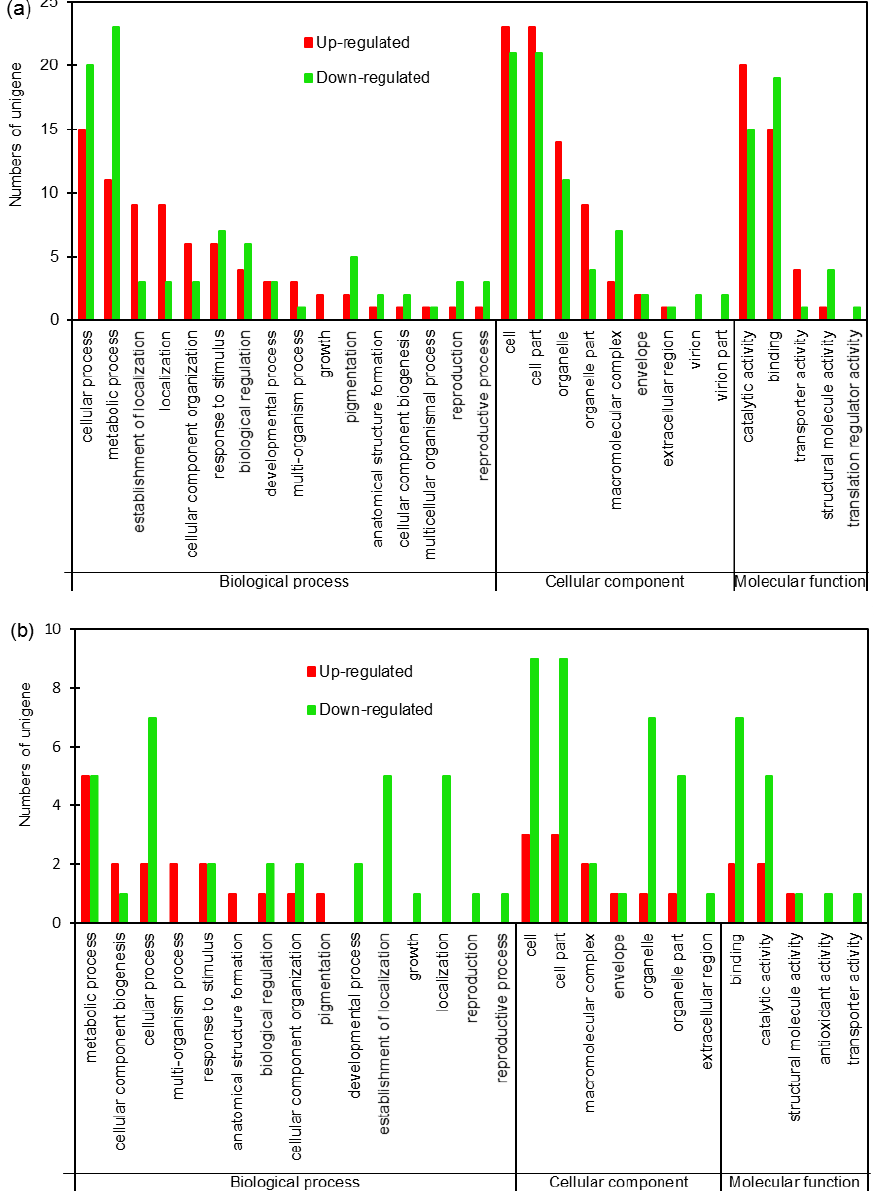
Figure 2. Gene Ontology (GO) analysis of the DEPs in roots ( a ) and shoots ( b ) of sugar beet exposed to salt condition. Red and green bars represent up- and down-regulated.